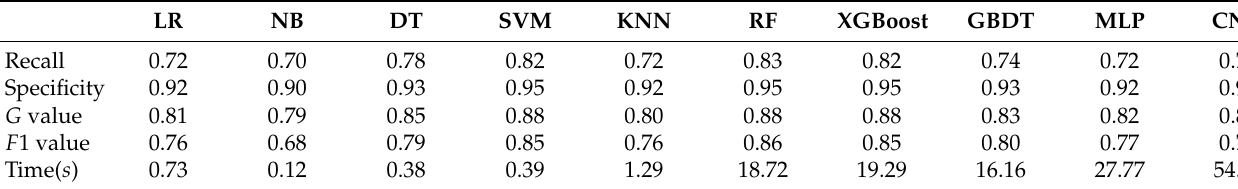
Table 7. Evaluation measures of each machine learning model in the multi-class balanced MEEI dataset.